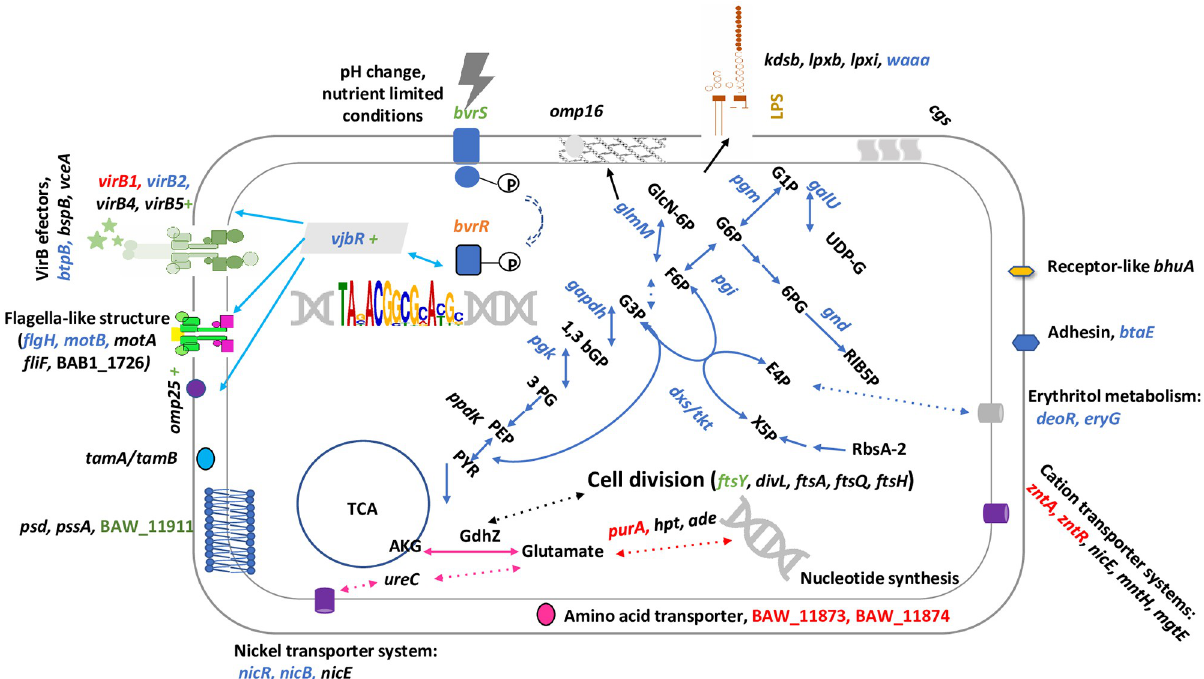
Fig 6. Putative BvrR/BvrS TCS regulon in B . abortus upon entry into the host cell. The recognition of the intracellular environment-associated cues by BvrS induces its autophosphorylation and consequently BvrR phosphorylation. As a result, BvrR-P increases its affinity for nucleotide regions similar to the consensus sequence, including its operon and regions encoding crossroad enzymes crucial for metabolic pathways required for intracellular trafficking. Genes according to the number of binding sites to BvrR-P found by ChIP-Seq are shown. Gene names with one binding site are in black, two binding sites: blue, three binding sites: green, four binding sites: orange, and five binding sites: red. Blue arrows indicate part of the energy metabolism, mainly the pentose phosphate cycle, erythritol metabolism, and Entner–Doudoroff pathway. The connection between the TCA cycle and nitrogen metabolism is represented with pink arrows. Light blue arrows represent VjbR targets. The green plus sign indicates positive regulation exerted by BvrR/BvrS. Pointed arrows indicate pathways partially represented.